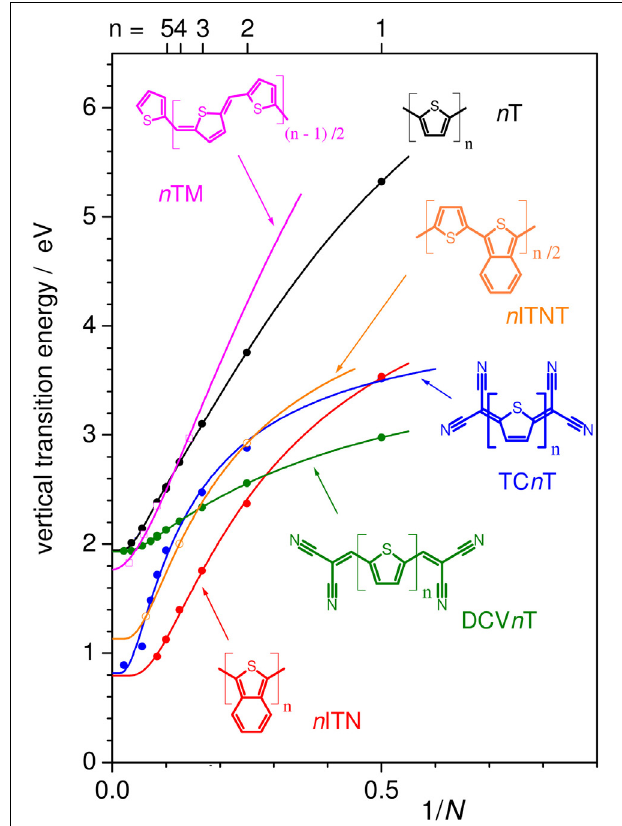
FIGURE 4 | E vert of different conjugated oligomers as a function of 1/N as calculated at the ZINDO/S level on DFT (B3LYP/6-311G ∗ ) optimized geometries. Solid lines for n T and n TM are fits according to the Kuhn equation ( Figure 2 ); for the DCV n T mono-exponential fits, and for n ITN and TC n T biexponential fits were